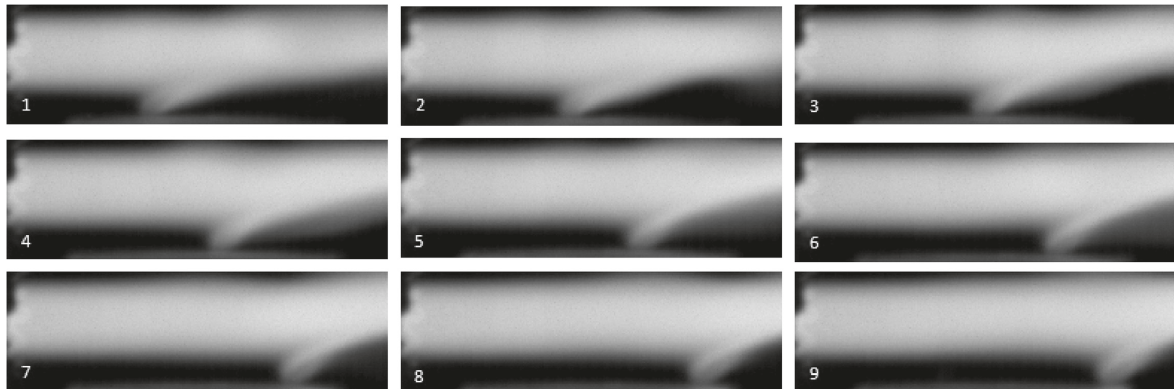
Figure 4: A sequence of images covering one period of the restrike process. Images come from a high-speed movie with 300,000fps; exposure time is 0.29 μ s.